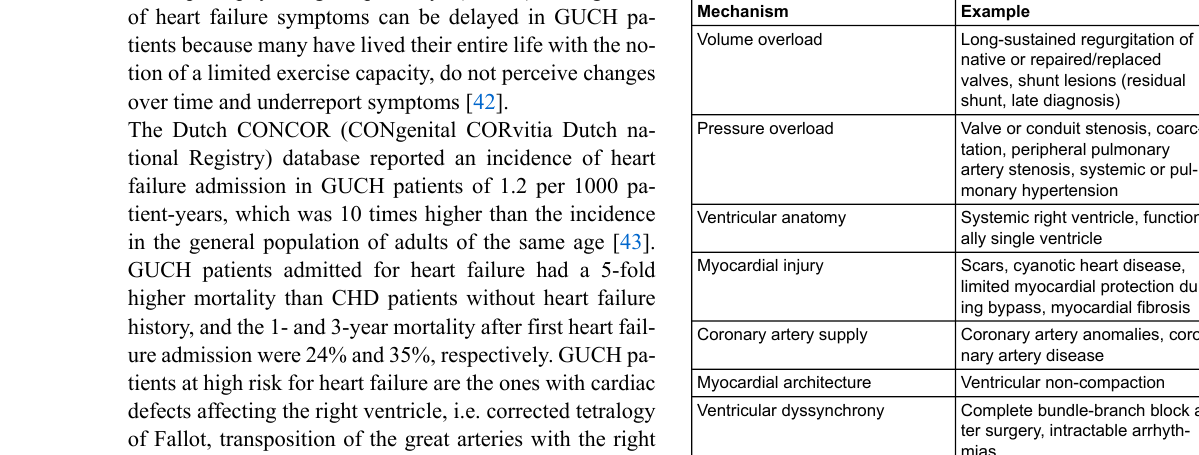
Table 5: Pathophysiology of heart failure in grown-up congenital heart disease patients. Mechanism